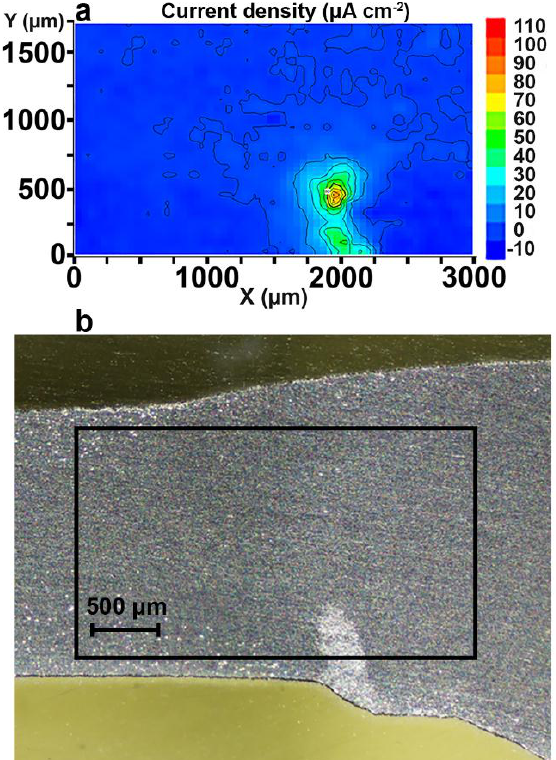
Figure 10. The ( a ) SVET data and ( b ) optical image of the mechanically treated sample after 87 h of immersion. The ( b ) presence of the defect in the bottom part of the welded joint area and ( a ) higher values of the current density in this zone revealed that the sample had undergone an intensive corrosion process.